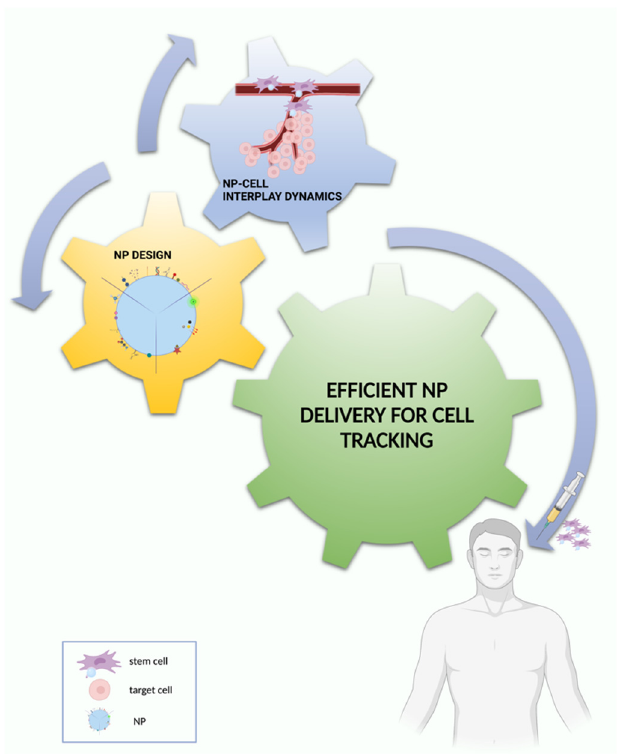
Figure 8. Essential ingredients for effective NP–cell tracking. NP design, cellular models and interaction mechanisms between NPs and cargo stem cells and/or target cells are key elements influencing NP-based cell tracking and delivery performances. Figure created with BioRender. Available